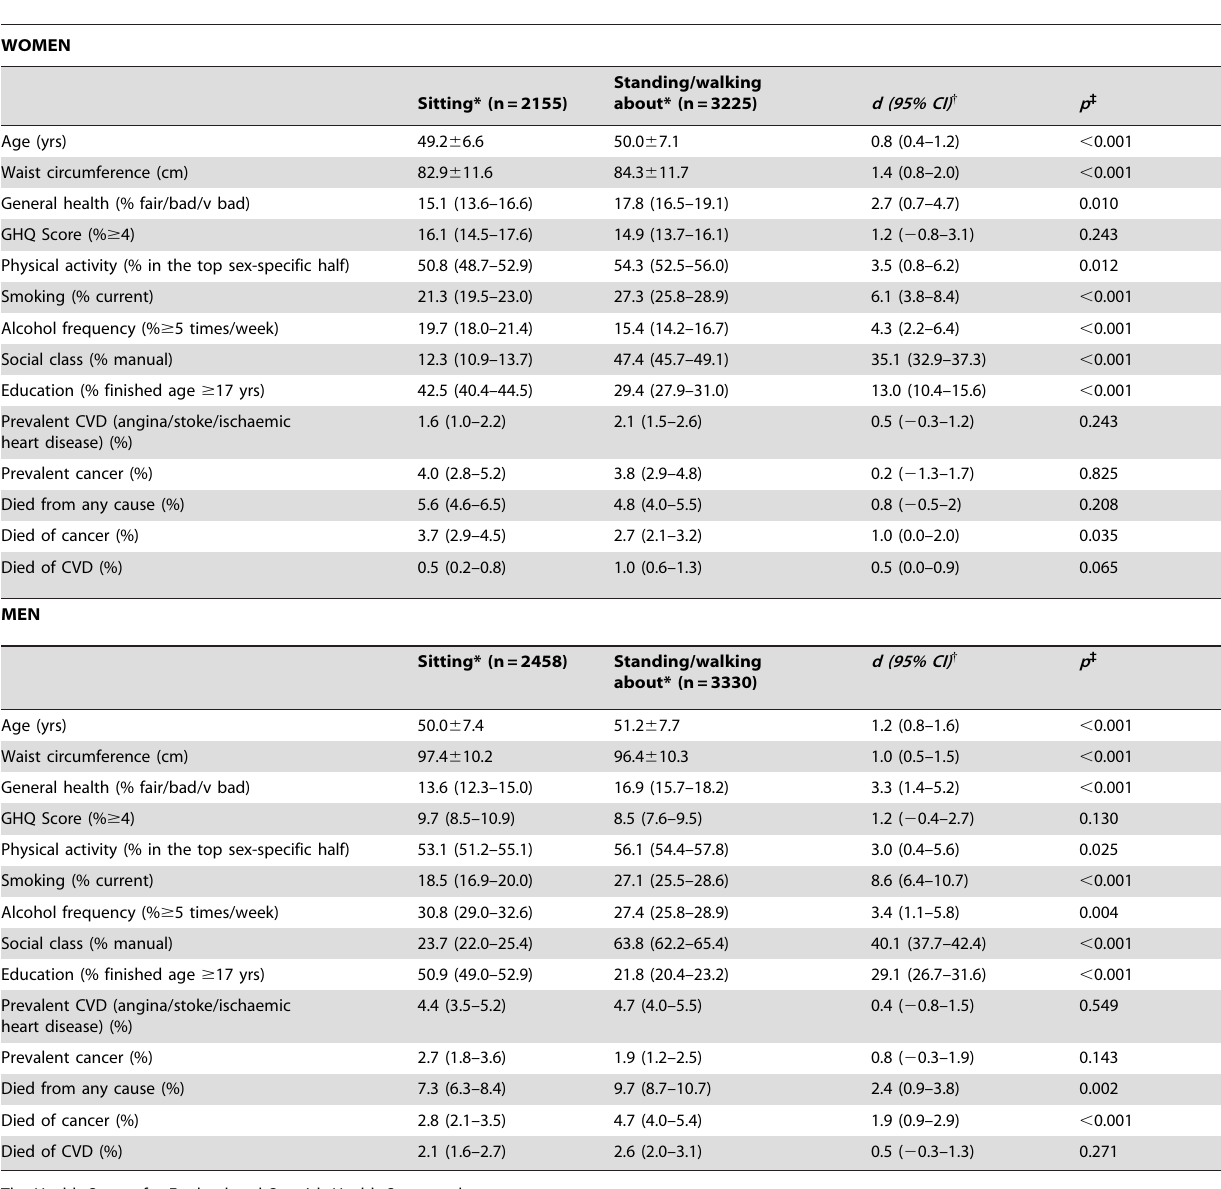
Table 1. Descriptive characteristics of women and men aged $ 40 years by main activity type while at work.